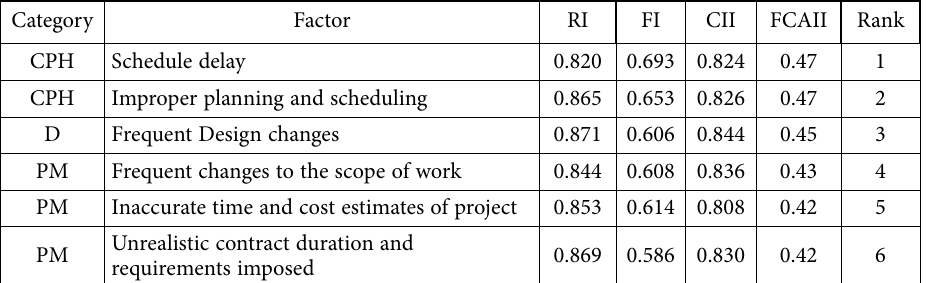
Table 2. RII, FI, CII and FCAII (values and rankings) of cost overrun attributes by all respondents.